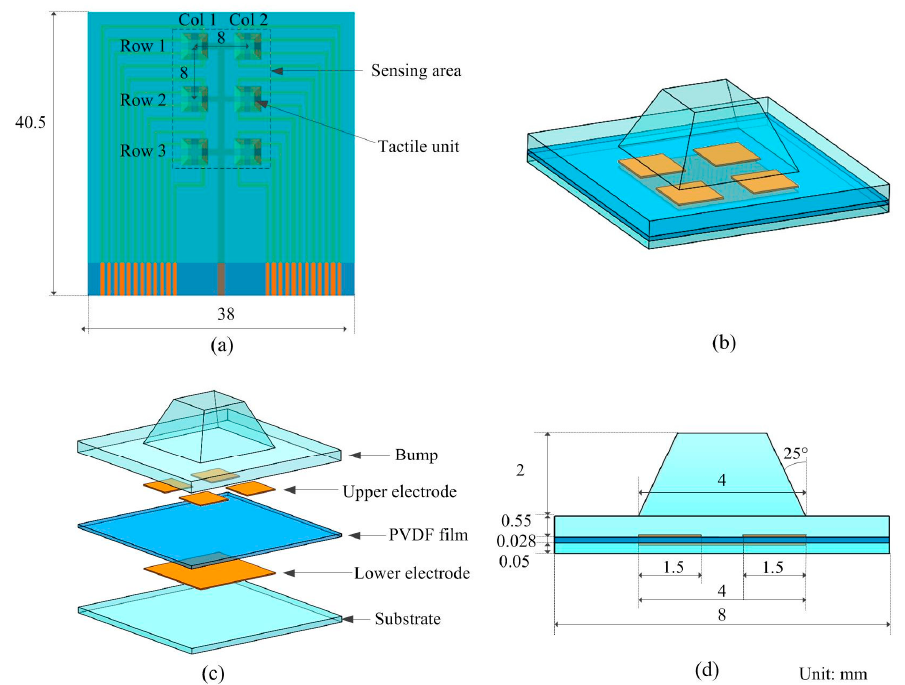
Figure 1. Conceptual diagram of the proposed three–axis tactile sensor array. ( a ) Top view of the array; ( b ) schematic view of a tactile unit; ( c ) exploded view of a tactile unit; and ( d ) cross-sectional view of a tactile unit.